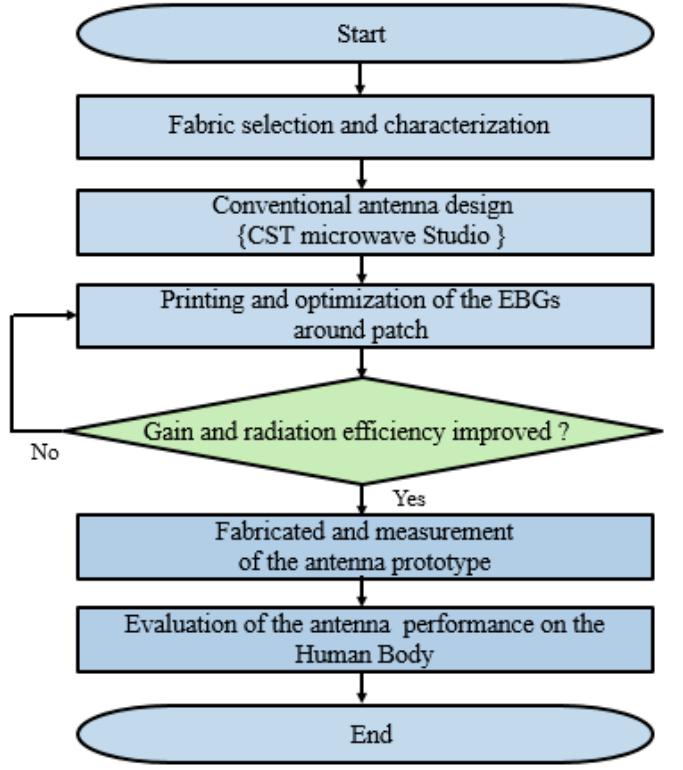
Figure 4. The flowchart describing the design procedure of the proposed textile antenna.